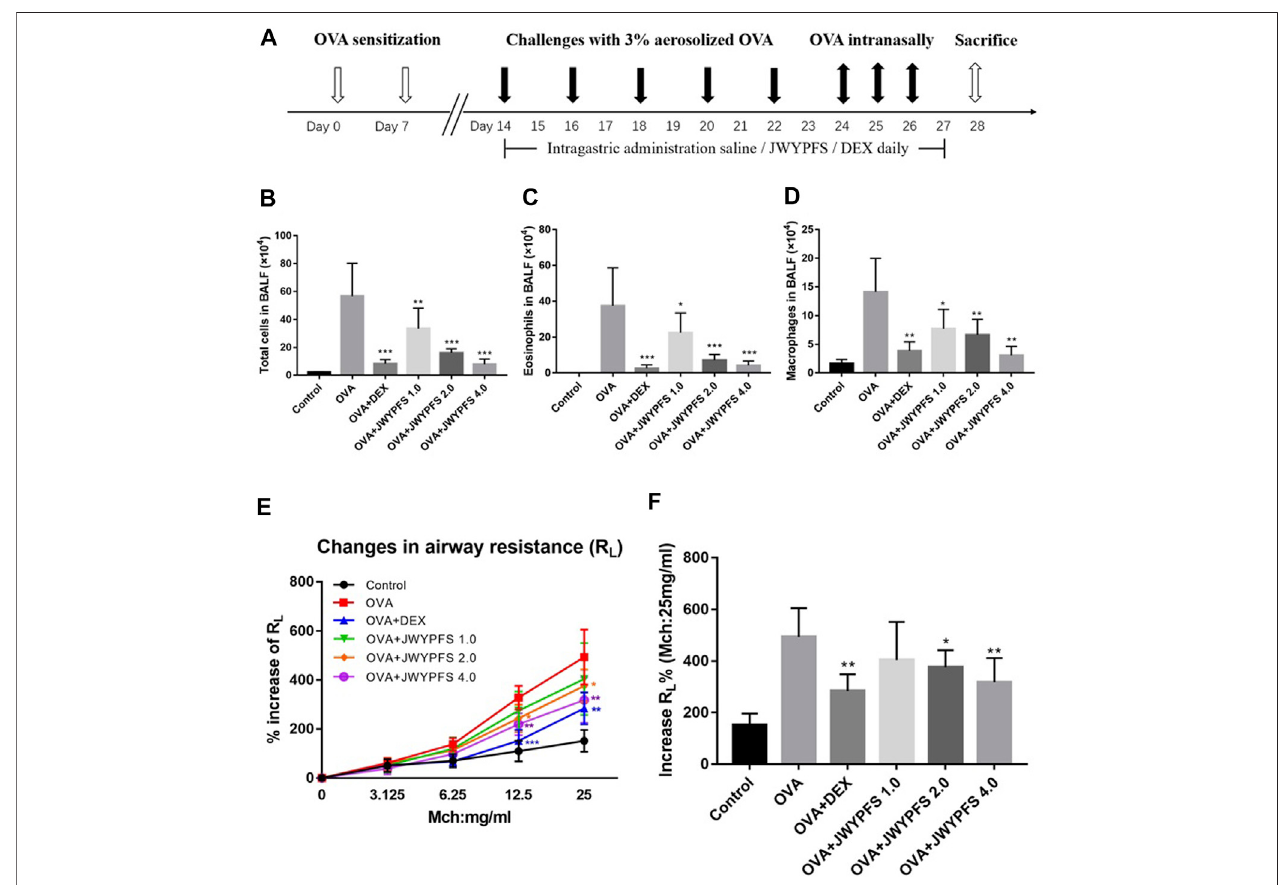
FIGURE 2 | The effect of JWYPFS on in fl ammatory cells in BALF and on airway resistance. (A) Schematic diagram of the establishment of an asthma model. (B) TotalcellsinBALF. (C) EosinBALF. (D) MacrophagesinBALF. (E) EffectofJWYPFSontheincreaseofR L %tomethacholine; (F) increaseofR L %(Mch:25 mg/ml).Data are shown as mean ± SD. * p < 0.05, ** p < 0.01, *** p < 0.001, compared with OVA group.